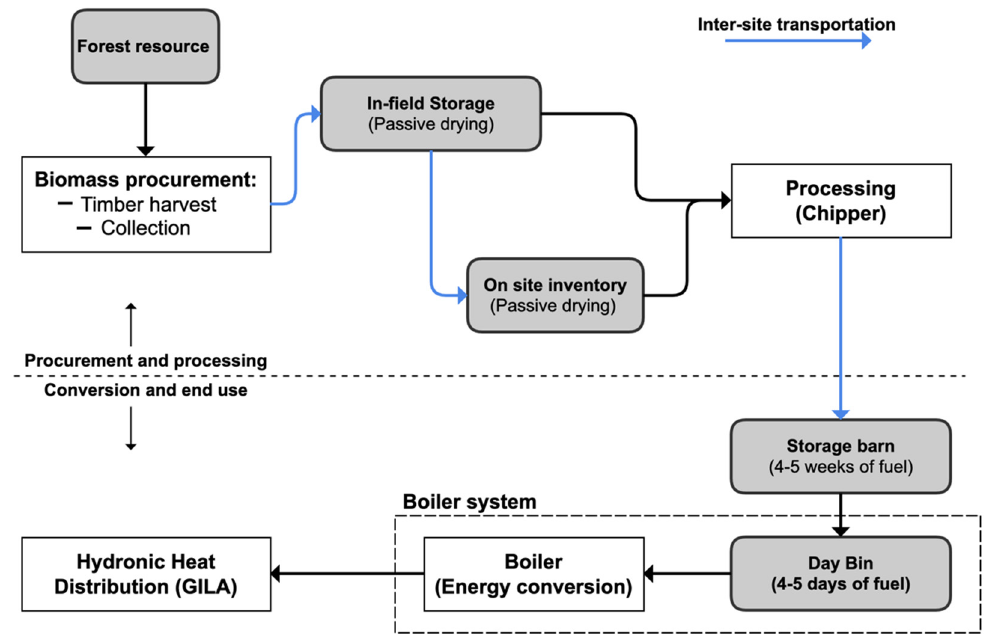
Figure 2. Schematic for Galena bioenergy project.